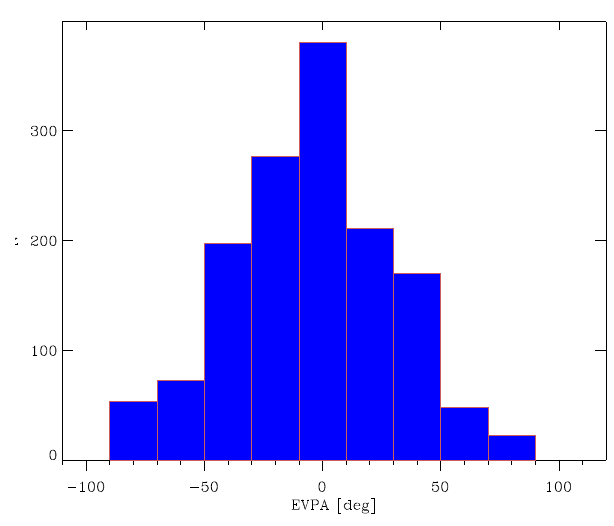
Figure 4. Histograms of electric vector polarisation angle (EVPA).